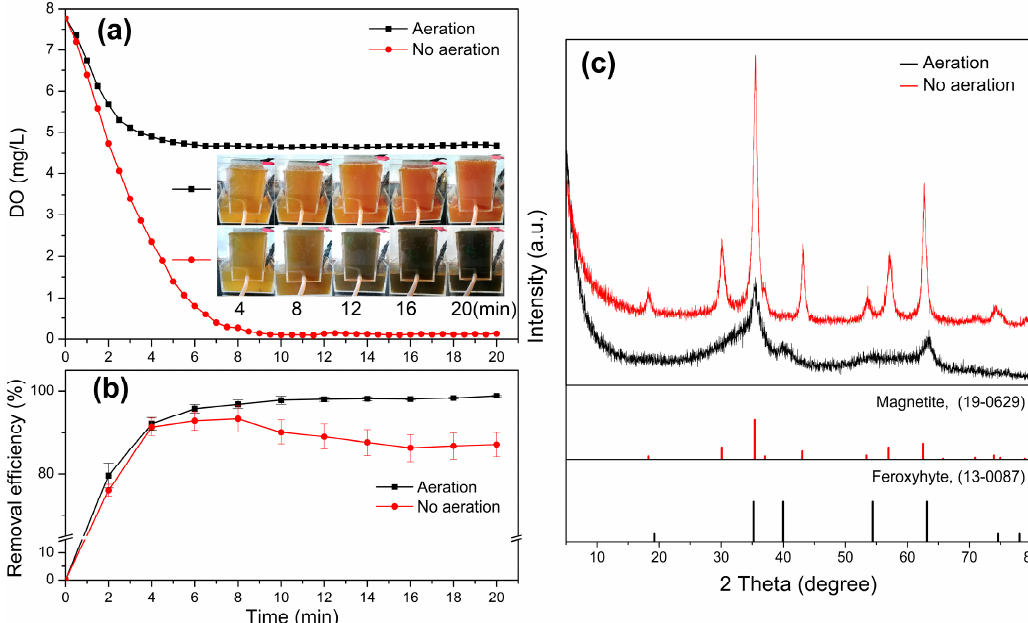
Figure 4. Effect of aeration of 0.2 L/min and no aeration on ( a ) Tl(I) removal efficiency, ( b ) dissolved oxygen (DO) concentration, and ( c ) X-ray patterns of flocculent sludge within a 20 min EC treatment under an applied current density of 16.7 mA/cm 2 at initial pH of 11 ± 0.1, using Fe–Fe electrodes at a distance of 2 cm. C 0 = 109 µg/L.